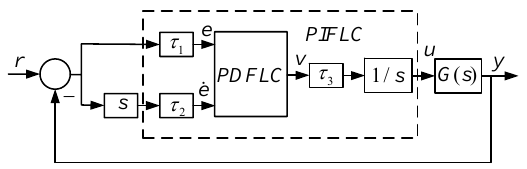
Fig. 1. The T-S PI fuzzy control system.